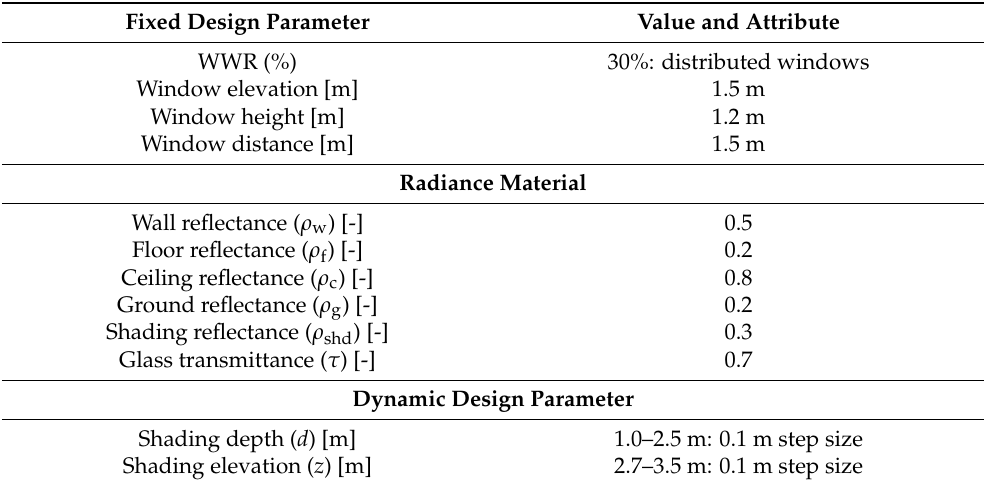
Figure 2. Digital model of the classroom with dynamic input variables, which are shading depth ( d ) and elevation ( z ). Table 2. Input variables.